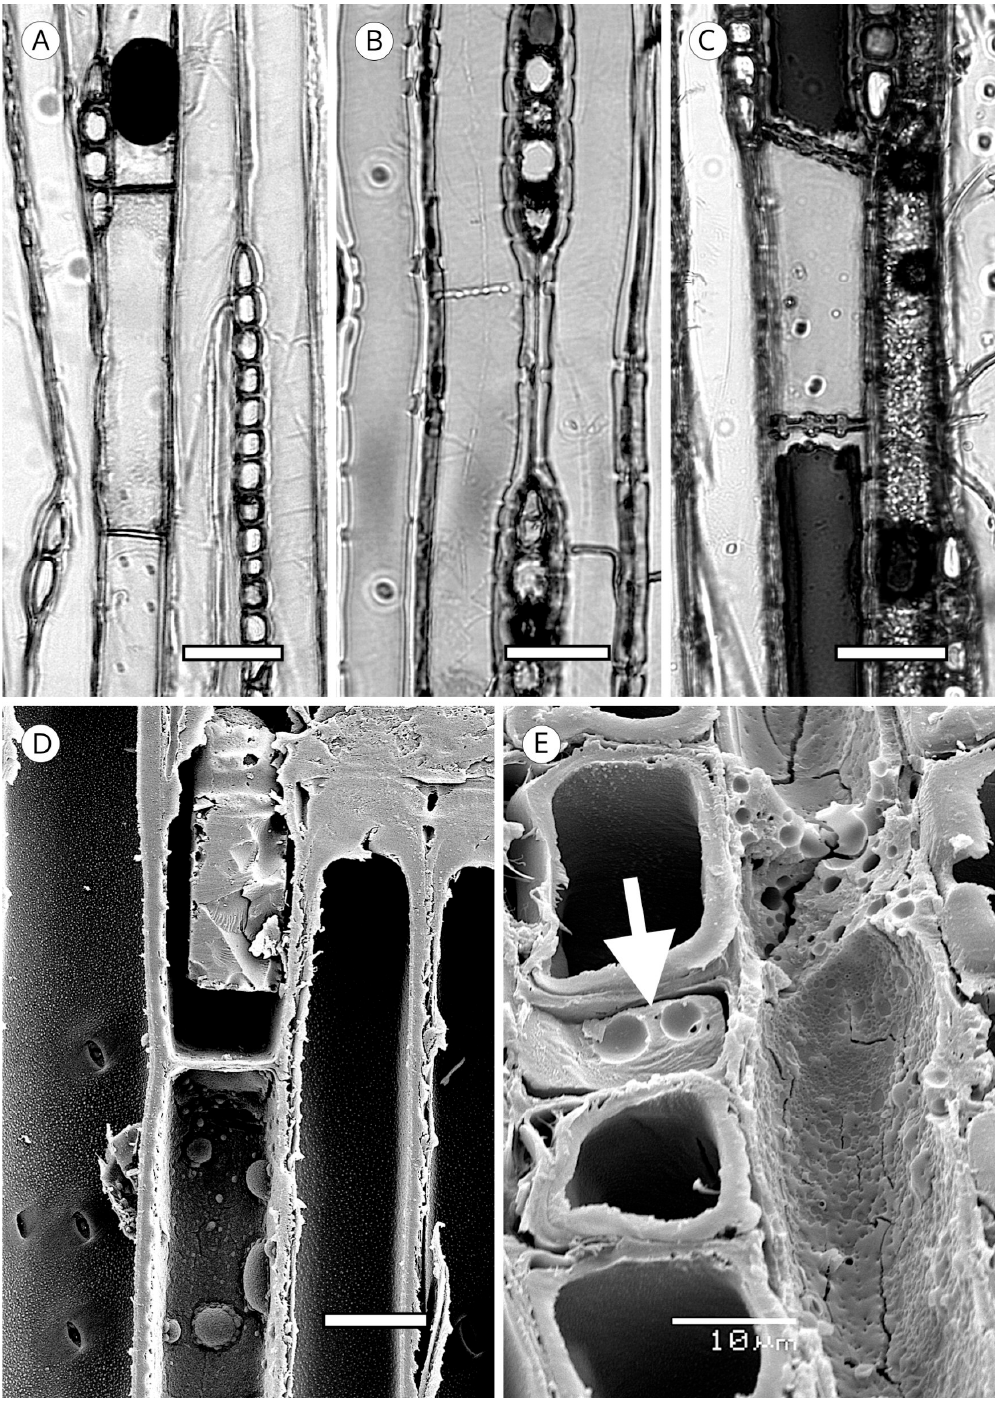
Figure 27. Transverse end walls of axial parenchyma. ( A ) Smooth in Cunninghamia konishii Hayata; ( B ) Irregularly thickened in Juniperus canariensis Guyot and Mathou; ( C ) Nodular in Taxodium distichum (L.) Rich.; ( D ) Smooth in Callitris robusta (SEM); ( E ) Nodular in Juniperus brevifolia (SEM). Scale bars. ( A ) = 50 μ m; ( B ) = 35 μ m; ( C ) = 50 μ m; ( D ) = 25 μ m.